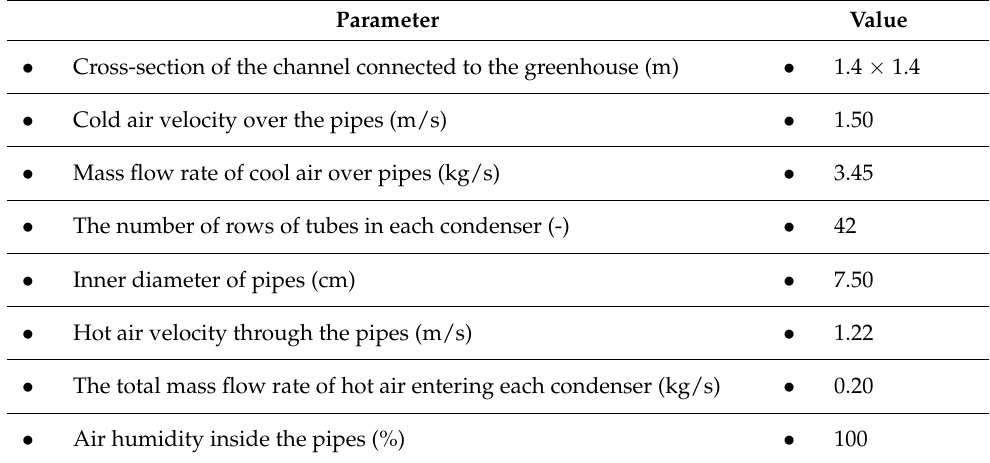
Table 1. Fixed parameters during the experimental tests on each condenser.